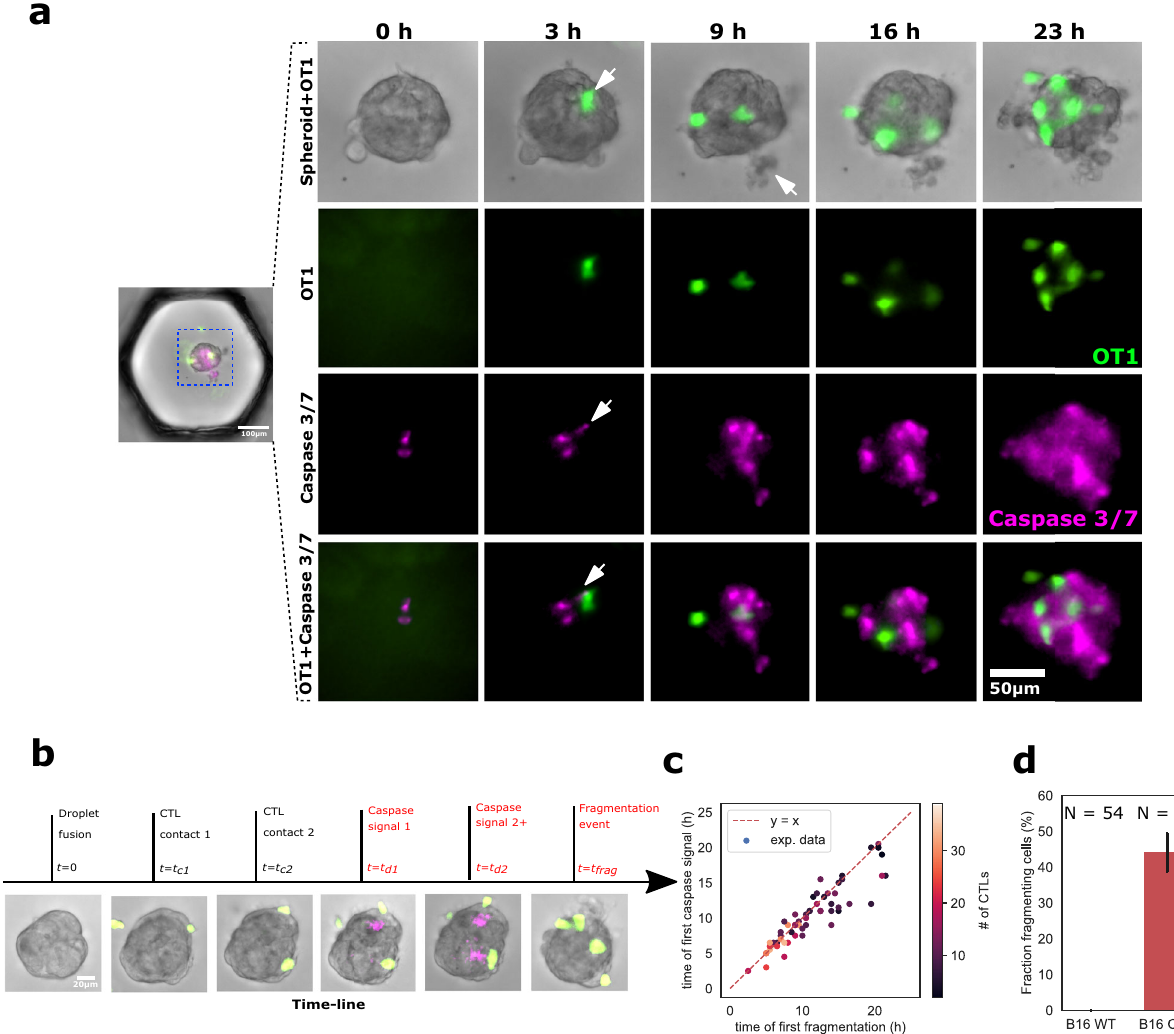
Fig. 4 CTLs kill tumor cells within spheroids. a Representative sequence showing CTL (OT1) positions on the spheroid, caspase 3/7 fl uorescent death marker, and B16 cell fragmentation. The white arrow at 3h indicates the appearance of capsase signal next to a CTL. At 9 h it represents a fragmented dead cell. b Representative chronology showing the key events for a given spheroid interaction with CTLs: Contact times of CTLs on spheroids, detection of caspase 3/7 signal, detection of fragmentation events. c Time of fi rst caspase signal vs. fi rst observation of cell fragmentation. d Percentage of WT (black) and OVA (red) spheroids that show at least one fragmentation event in under 14 h. N equals 54 and 84 spheroids, respectively. The error bar is the SEM. Source data are provided as a Source data fi